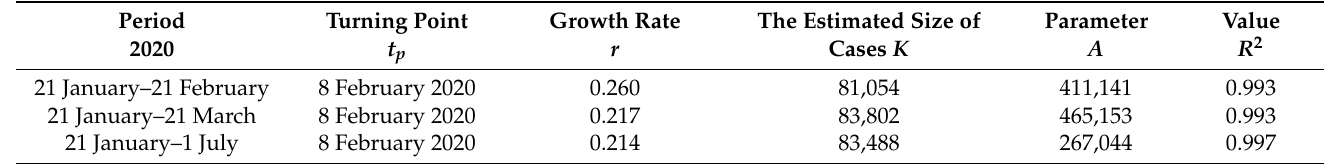
Table 1. The results of estimated parameters in the logistic growth model for various periods that are compared by daily cases data of COVID-19 infected in China based on data compiled by WHO [18]. Period